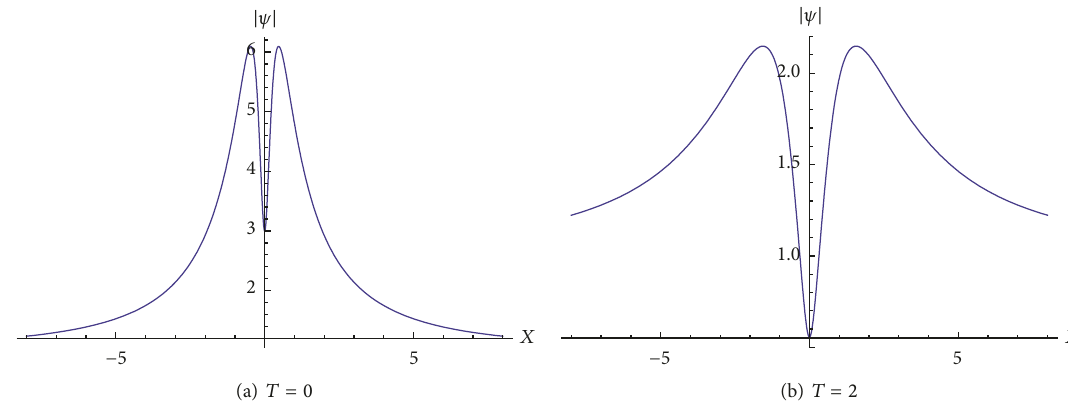
Figure 23: Dynamical evolutions of the rouge wave structure determined by the module of solution